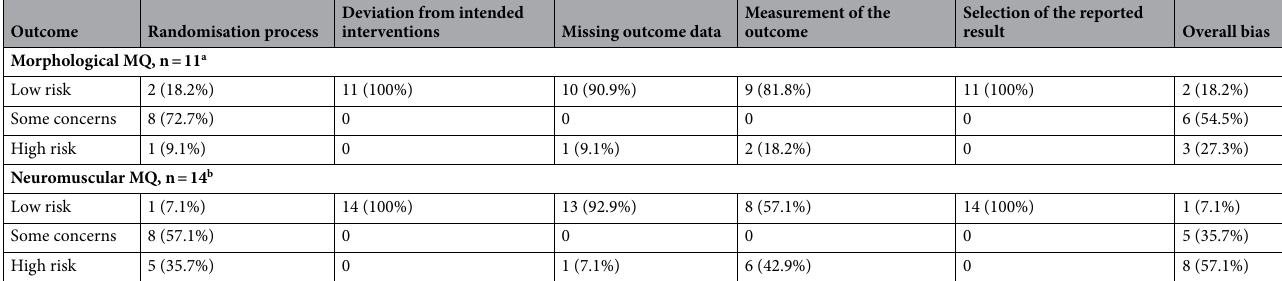
Table 1. Risk of bias of included studies. MQ, muscle quality; n, number of studies. a Intention-to-treat analyses, n = 8 and per-protocol analyses, n = 3. b Intention-to-treat analyses, n = 5 and per-protocol analyses, n =